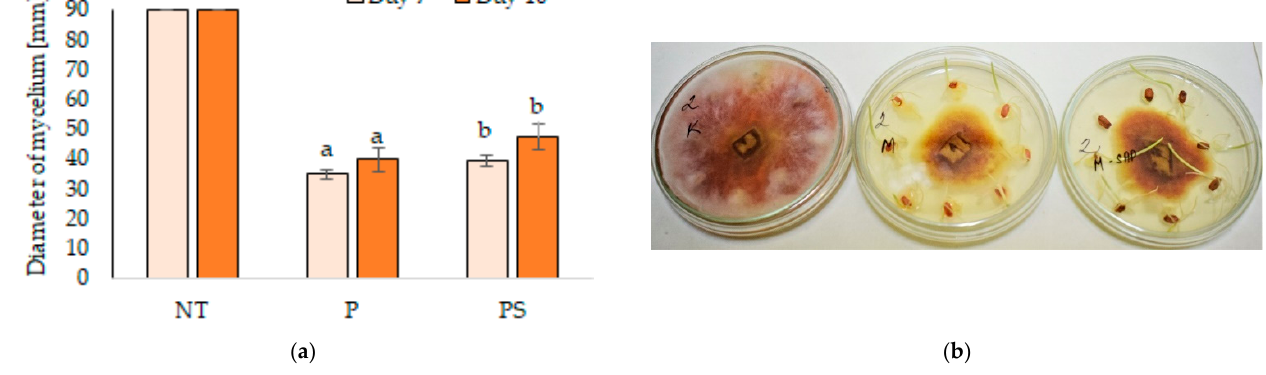
Figure 1. Inhibition of ( F. culmorum ) mycelial growth by seed dressing with pesticides combined with or without SAP coating. ( a ) Inhibition of fungal growth expressed by the fungal mycelium diameter (NT–control seeds, P–seeds dressed with pesticides, and PS–seeds dressed with pesticides and coated with SAP). The errors of the mean values are expressed as standard deviation (± SD). Different letters indicate statistically significant differences by LSD test ( α = 0.05), a statistical test was done separately for each term. ( b ) Growth of fungal mycelium ( F. culmorum ) on plates with wheat seeds, from left: Control–not treated seeds, seeds dressed with pesticides, and seeds dressed with pesticides and coated with SAP.